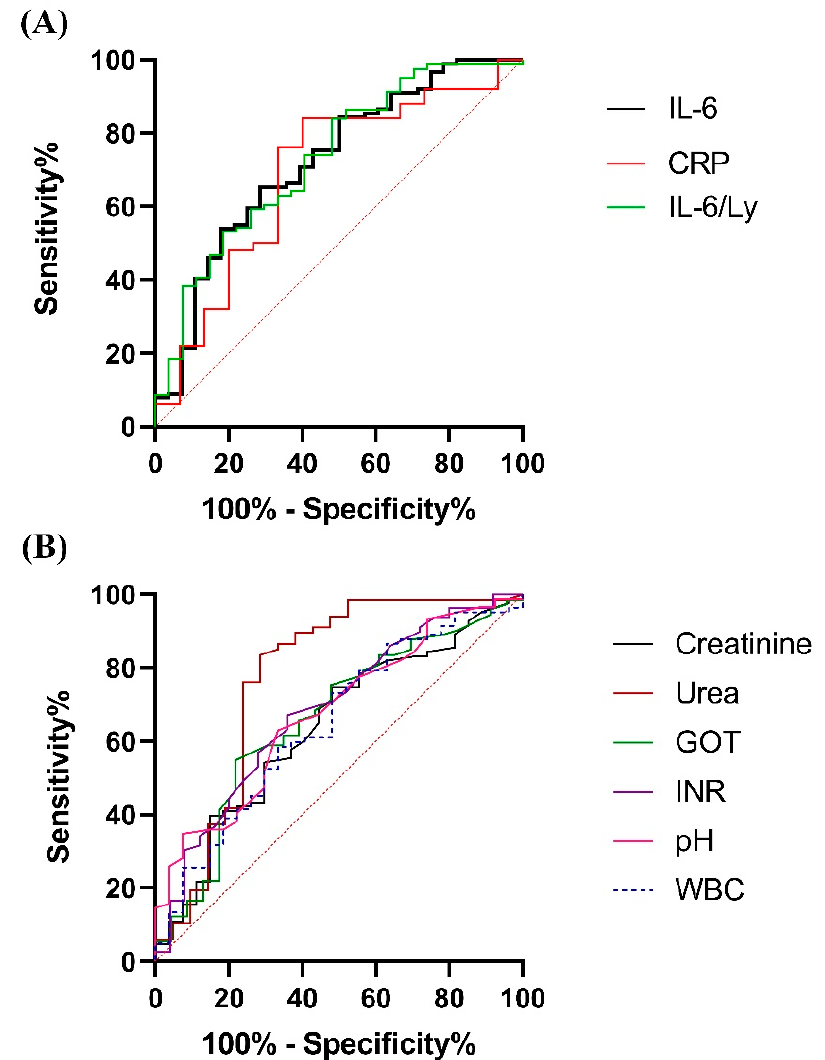
Figure 1. ROC curves for ( A ) inflammatory biomarkers (IL-6, CRP, IL-6/Ly); ( B ) routine laboratory parameters (creatinine, urea, AST, INR, pH and WBC).